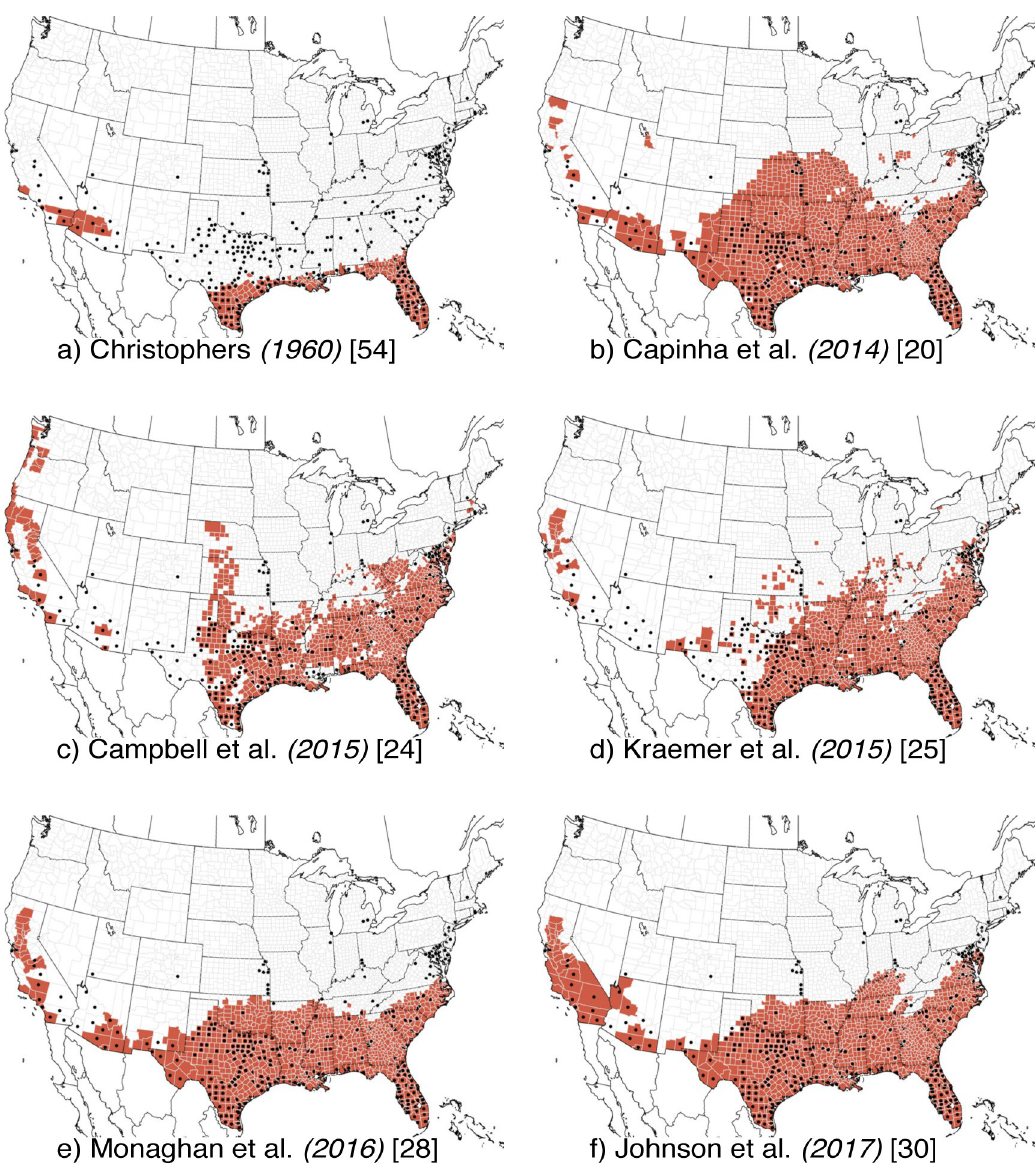
Fig 2. Reproduced Ae . aegypti models. Distribution models reproduced from (a) Christophers (1960) [54], (b) Capinha et al. (2014) [20], (c) Campbell et al. (2015) [24], (d) Kraemer et al. (2015) [25], (e) Monaghan et al. (2016) [28], and (f) Johnson et al. (2017) [30]. Red areas are predicted to be environmentally suitable for presence. Black dots are all presence records.